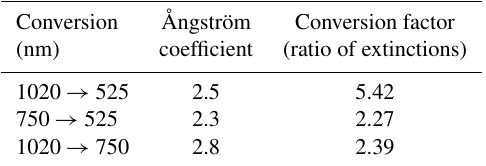
Table 2. Conversion factors for aerosol extinctions measured at var- ious